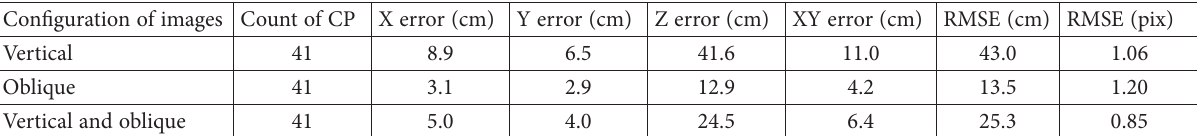
Table 3. Detailed distribution of model fitting errors at check points for the analyzed image variants, assuming the knowledge of the